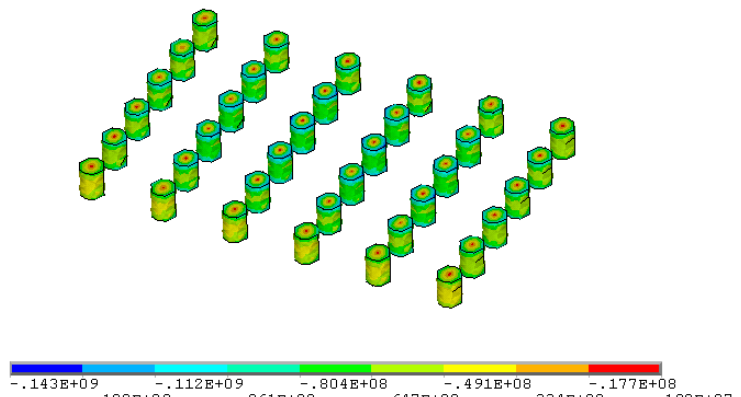
Figure 17. Minimum principal stress distribution of scheme 1 pillars at 1480 mL (parameters of scheme 1: stope height 2.5 m, pillar diameter 2 m, pillar spacing 4 m, pillar row spacing 6